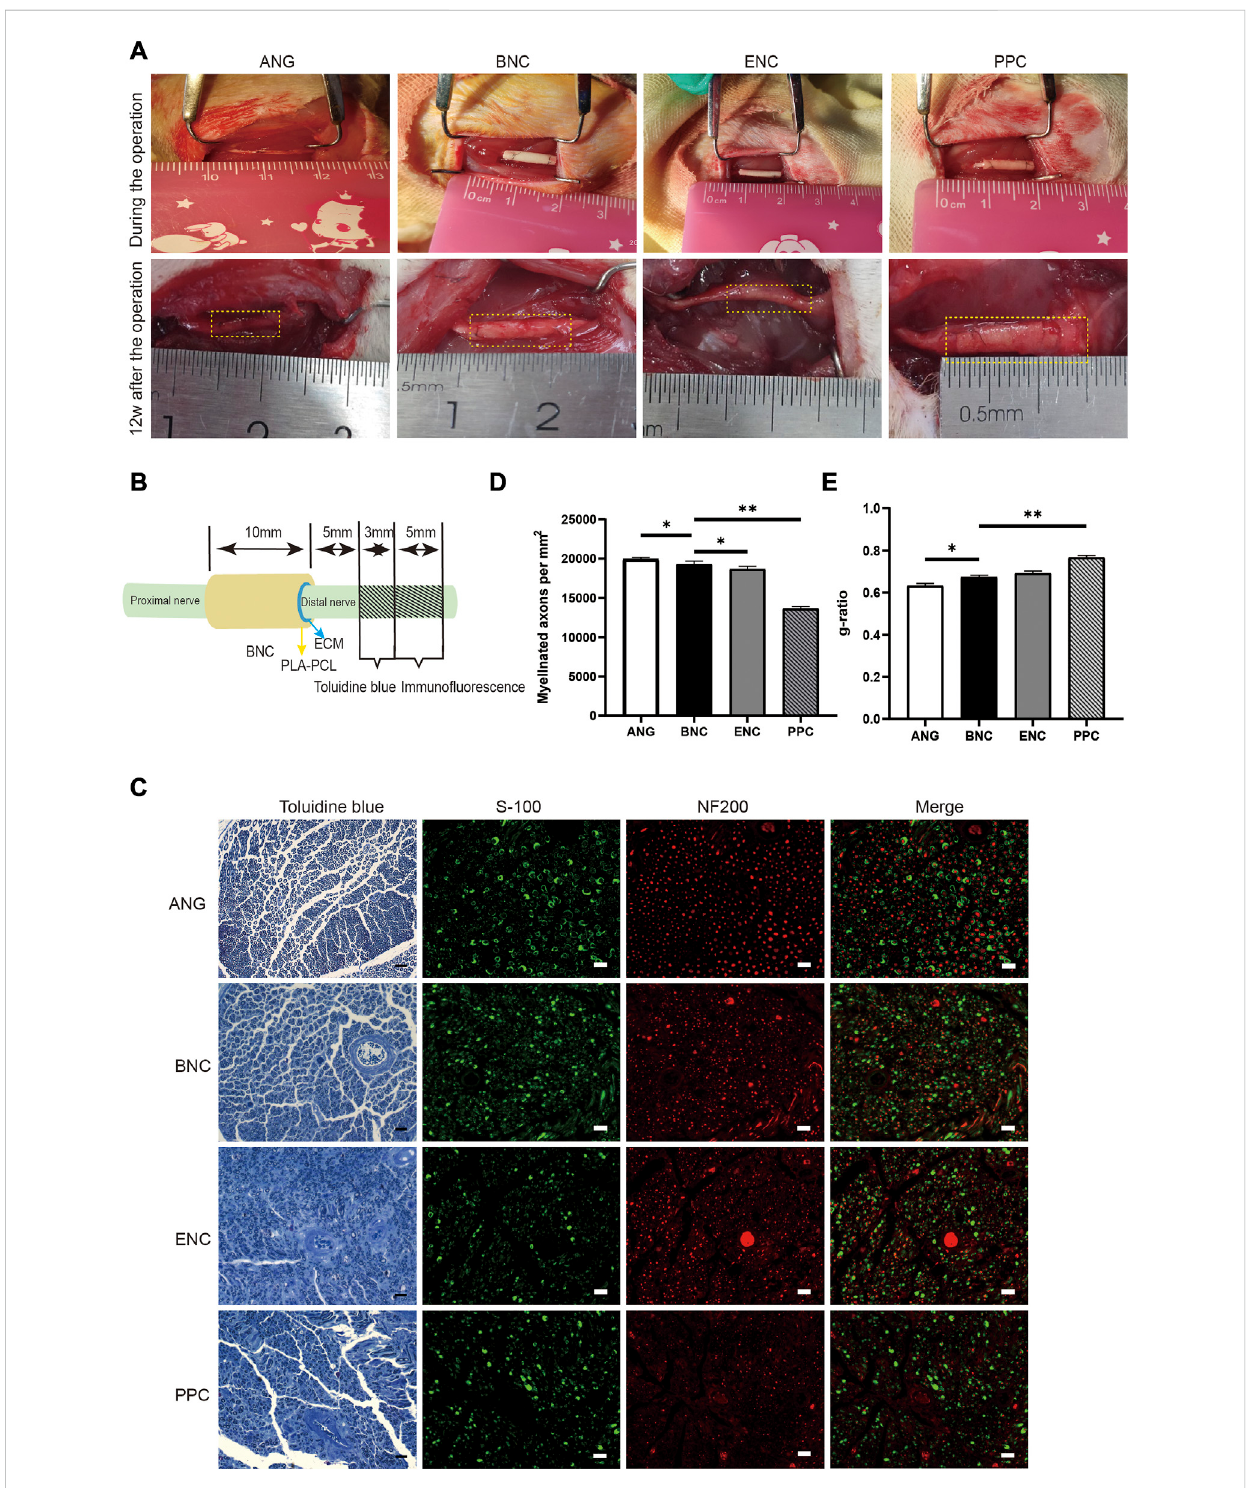
FIGURE 8 Implantation,observation aftertheoperation,andtheassessmentoftheregeneratedaxonsandmyelinsheathsindifferentgroups. (A) Theconduits implanted in 10-mm rat sciatic nerve defect and observed at 12 weeks after surgery. (B) Schematic diagram of the sampling locations for toluidine blue staining and immuno fl uorescence assay. (C) Toluidine blue staining of the regenerated myelin sheath at 12 weeks after surgery. Scale bar = 20 μ m. (D) Histogramofthemyelinatedaxonnumbers/HPFat12 weeksaftersurgery. (E) Histogramoftheg-ratioat12 weeksaftersurgery.Dataareexpressed as the mean ± SD ( n = 5) (ns > 0.05, * p <